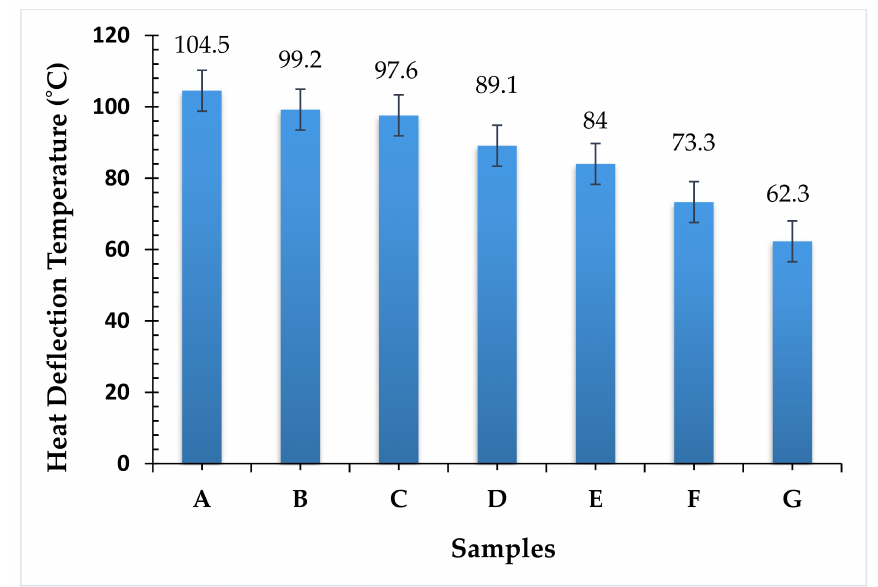
Figure 5. SEM image of hybrid composite laminates.